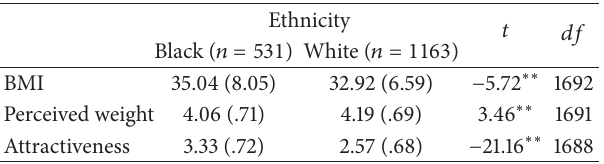
Table 1: 𝑡 -test results for ethnic differences in BMI, perceived weight, and